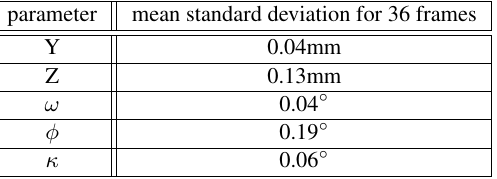
Table 4: Mean accuracy of relative orientation between one im- age